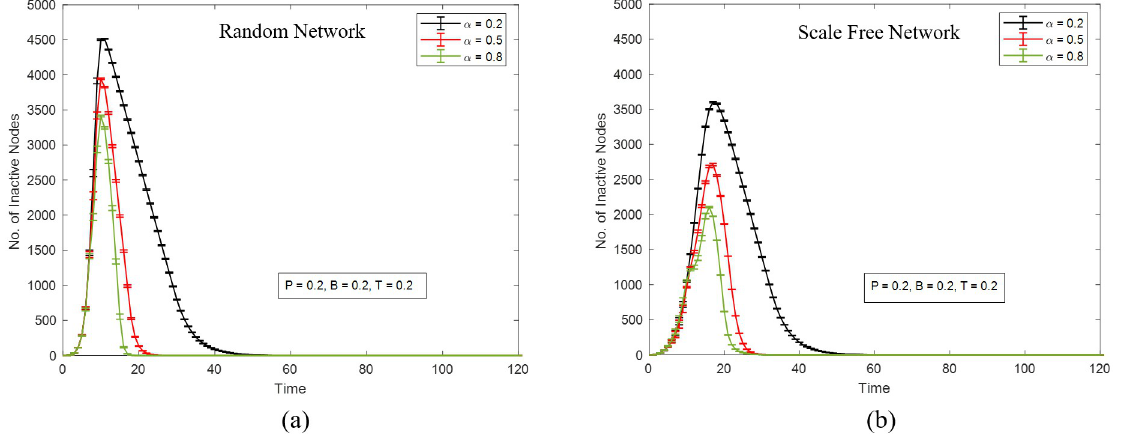
Fig 1. The number of inactive nodes as a function of time steps in (a) a random network and (b) a scale-free network. Both networks have 5000 nodes and 10000 links. T = B = P = 0.2, and α takes three values: 0.2 (black curve), 0.5 (red curve), and 0.8 (green curve). Each data point is the average of results of 20 iterations of simulation (each with the same initial attack targets). The error bars indicate standard